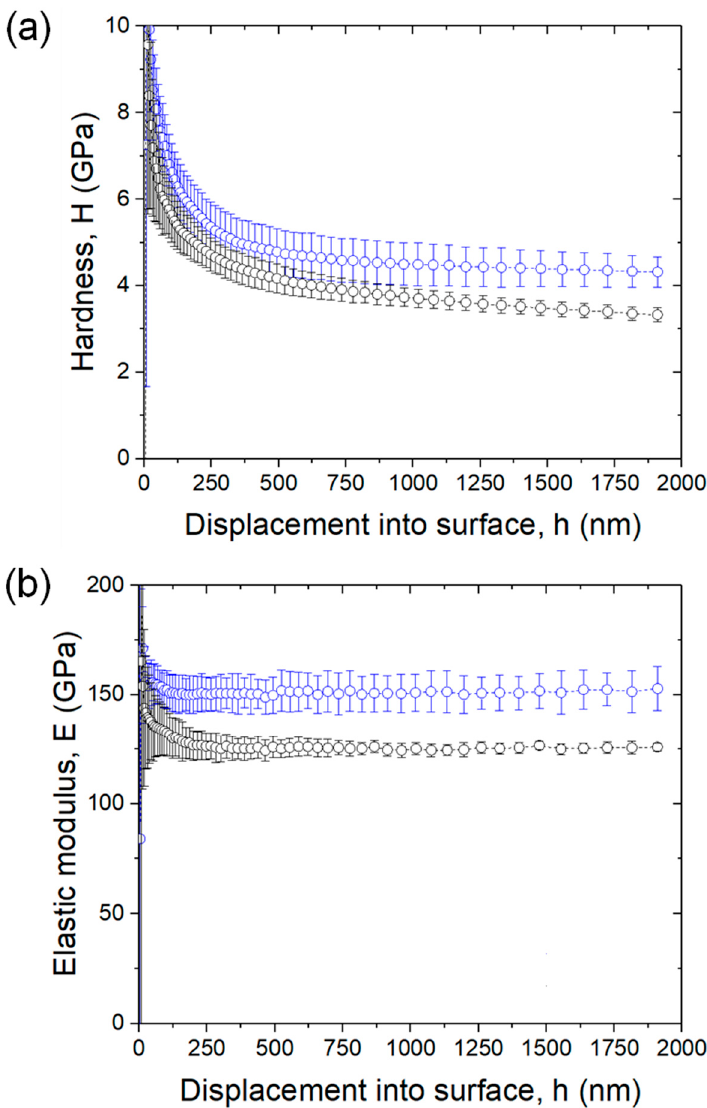
Figure 7. Micromechanical properties: ( a ) hardness and ( b ) elastic modulus vs. displacement into the surface; a function of the loading direction (LD and TD in black and blue, respectively).